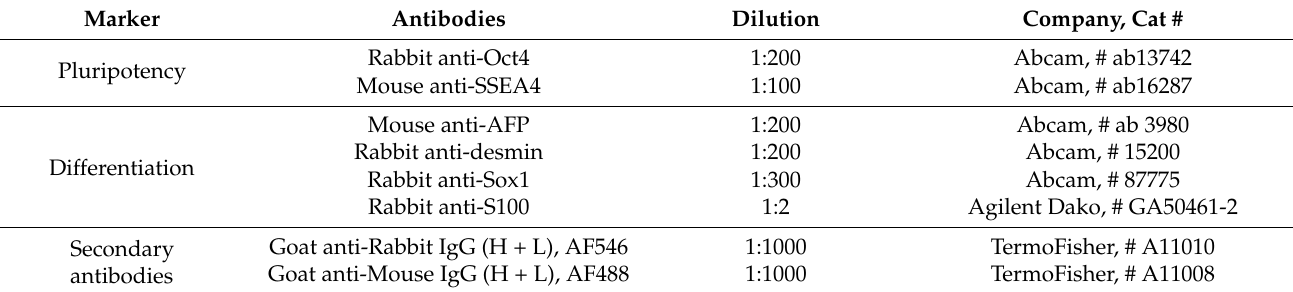
Table 2. Antibodies used in the